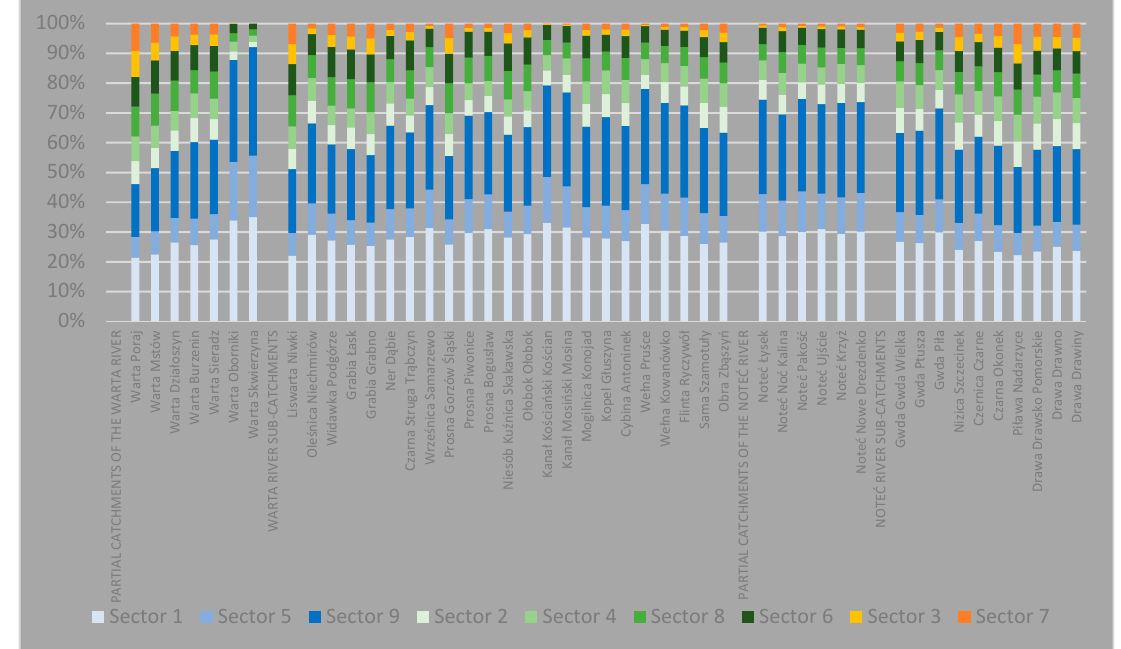
Figure 4. The percent share of separated types of the annual maximum specific runoff (AMAXq) dependencies between analyzed sub-catchments and the Gorzów Wielkopolski gauge closing the Warta River catchment (WRC) (in the hydrographic order).